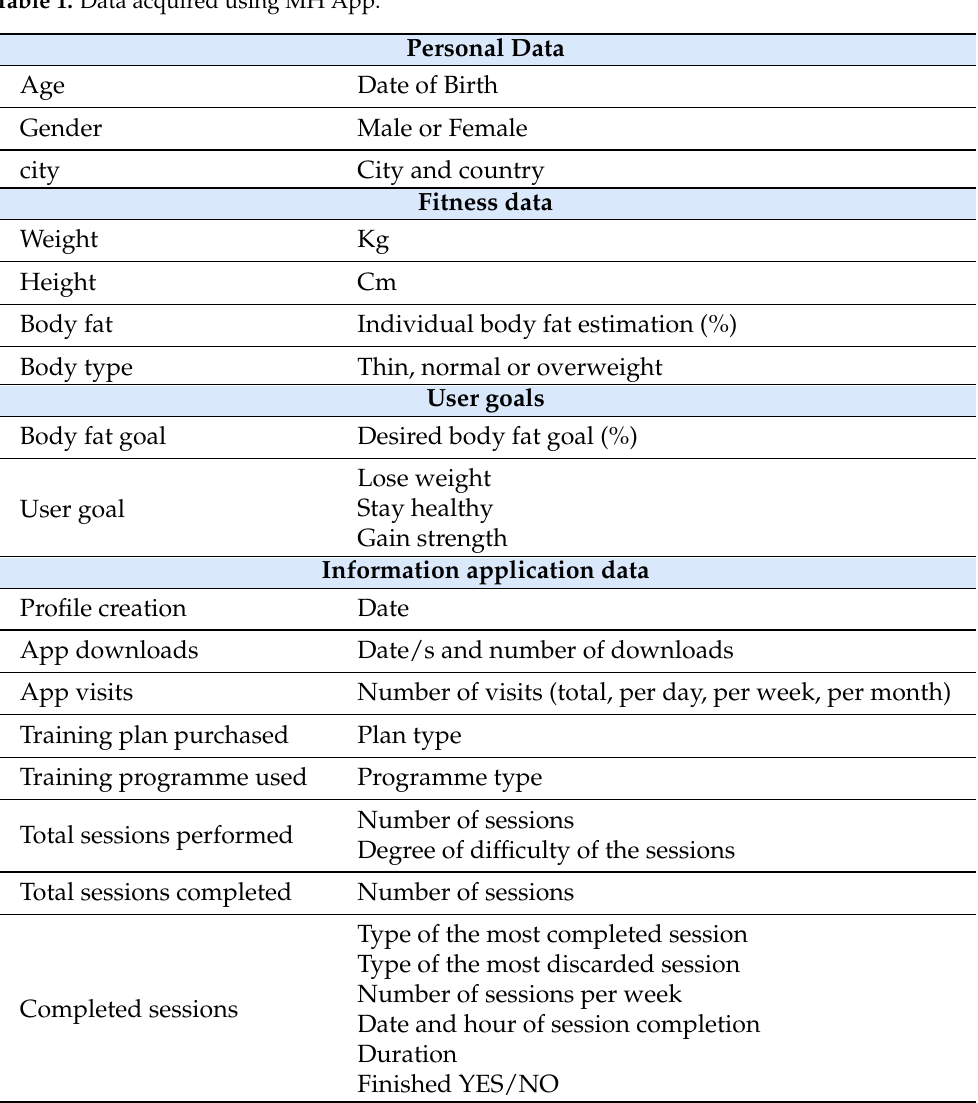
Figure 1. Illustration of MH app usage. Table 1. Data acquired using MH